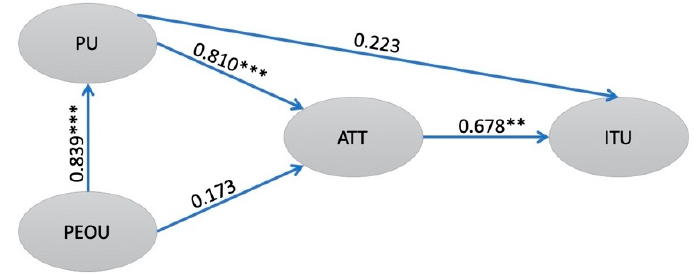
Figure 4. Technology acceptance model (TAM) results (** p < 0.01, *** p < 0.001).